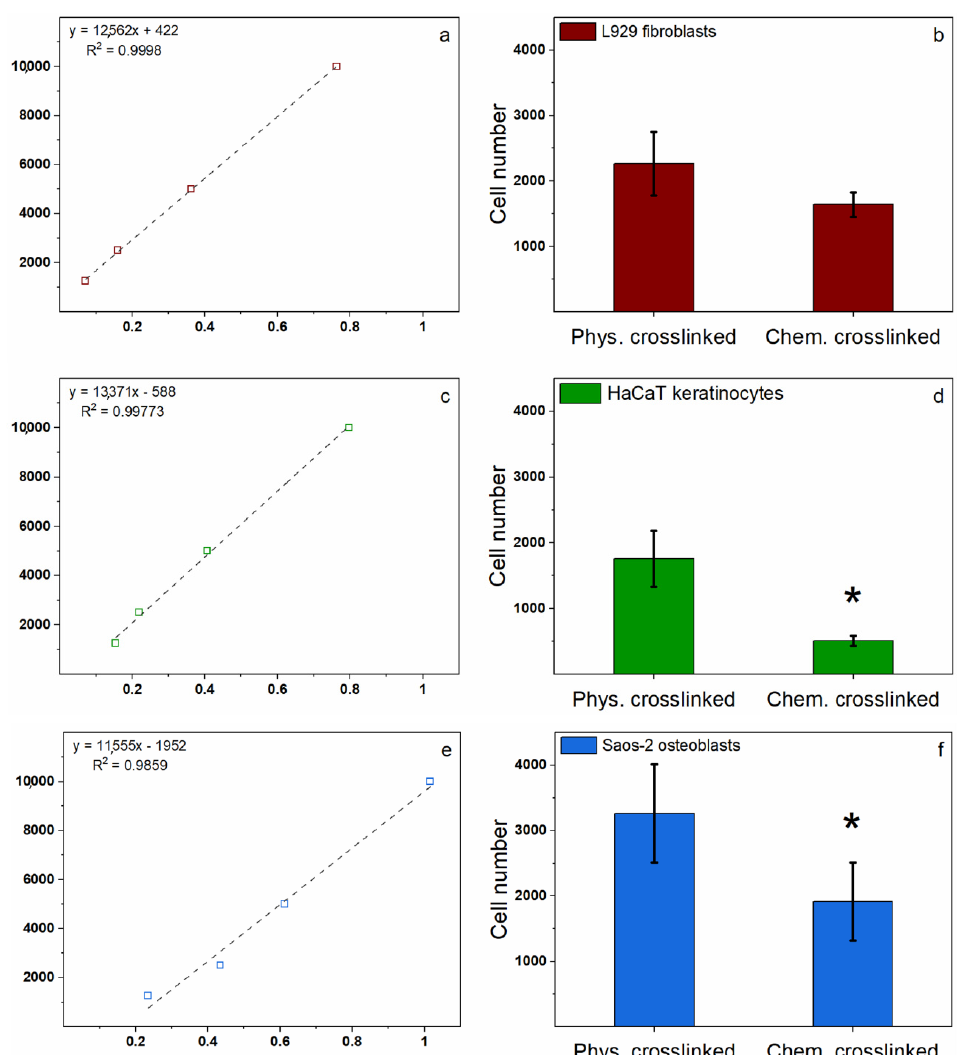
Figure 5. Cell adhesion evaluated by MTT test of attached cells after 16 h incubation. ( a ) L929 murine fibroblasts linear regression graph obtained by seeding doubling numbers of cells from 1250 to 10,000. The graph shows the trend line equation and the R2 data correlation. ( b ) L929 cell adhesion to the physically (Phys-cross) and chemically (Chem-cross) crosslinked membranes. Results are expressed as the number of adhered cells to each type of membrane obtained by interpolation to the standard regression curve shown in ( a ). They are the mean ± S.D. of 3 experiments performed in triplicate. ( c ) HaCat human keratinocytes linear regression graph obtained as in ( a ). ( d ) HaCaT cell adhesion obtained as in ( b ). Asterisk indicates significance in the T -test (* p < 0.05). ( e ) Saos-2 human osteoblasts linear regression graph obtained as in ( a ). ( f ) Saos-2 cell adhesion obtained as in ( b ). The asterisk indicates significance in the T -test (* p <